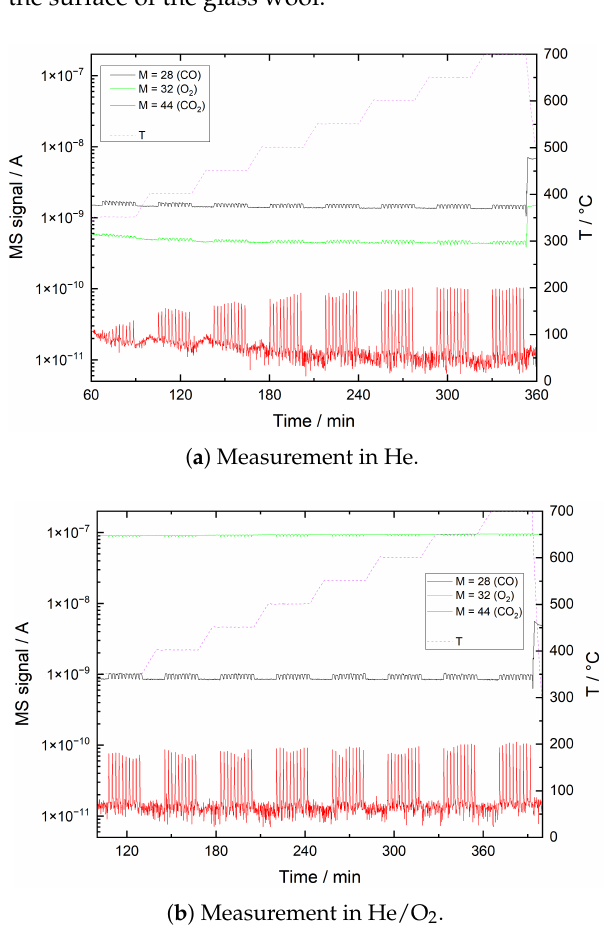
Figure 13. CO pulse measurement, reference measurement without sample recorded in ( a ) He and ( b ) He+12.5vol% O 2 (He/O 2 ) at 8 different temperature levels. The plots show mass spectrometer signals for mass numbers 28 (CO), 32 (O 2 ) and 44 (CO 2